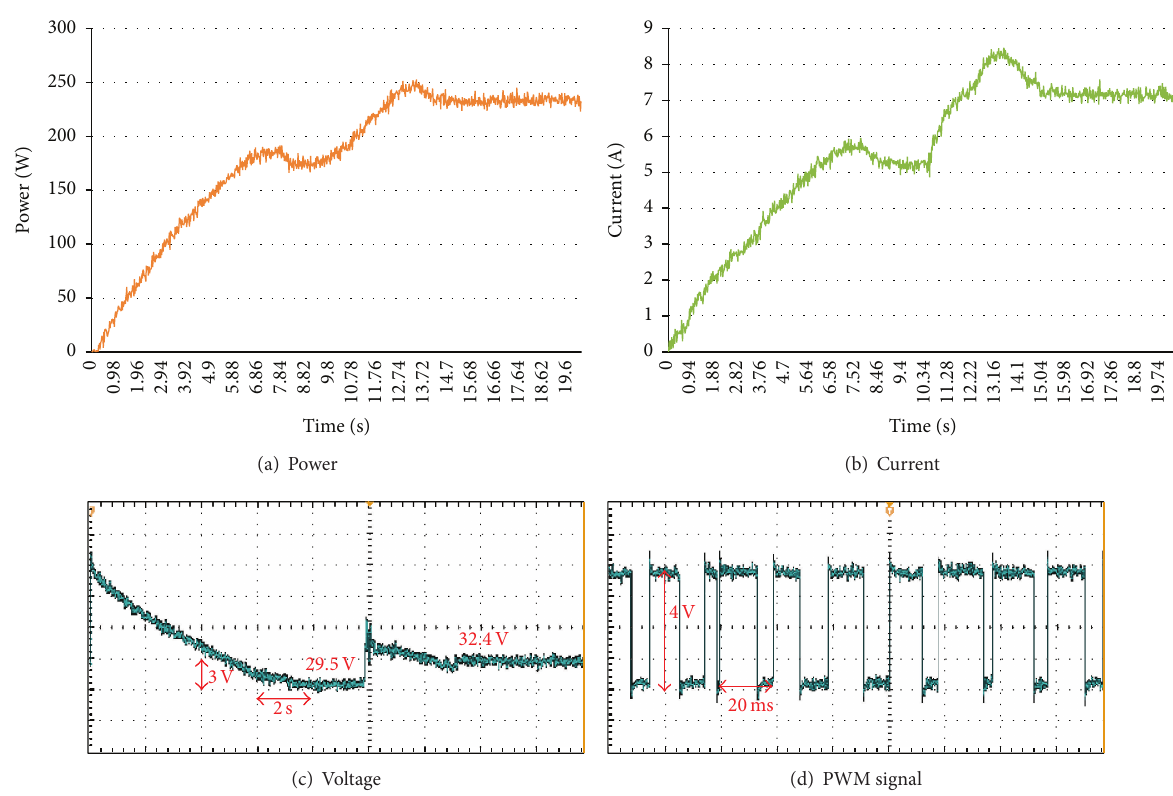
Figure 16: Tracking performance of the gradient-based extremum seeking MPPT algorithm under nonuniform irradiance.